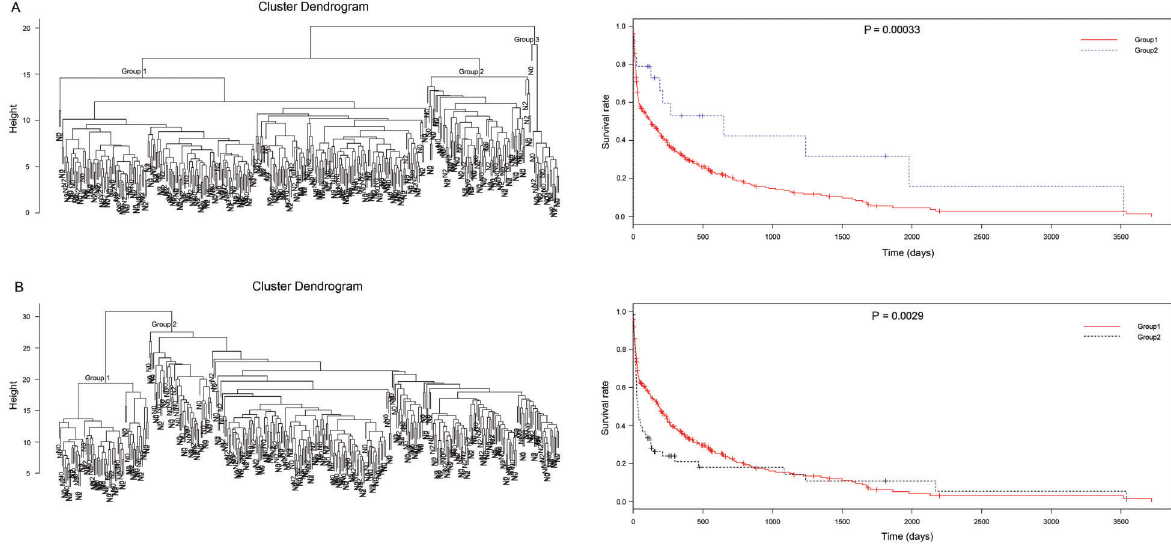
Figure 5. Sample clustering based on yellow ( A ) and turquoise ( B ) module factors and differences in survival curves of the two groups of samples. Table 2. Genes with top signi fi cance of COX univariate regression in the yellow and turquoise modules. Gene symbol P value